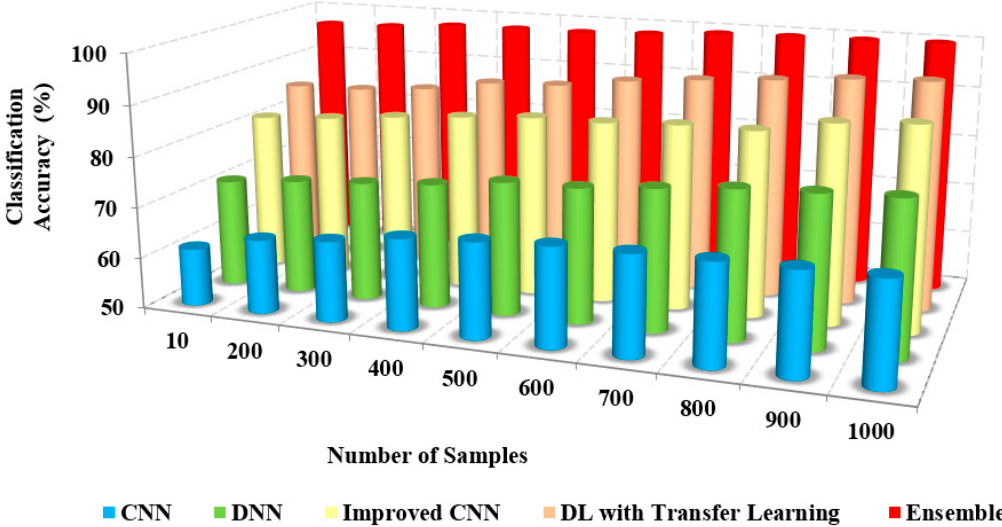
Figure 7. Number of samples vs. classification accuracy.